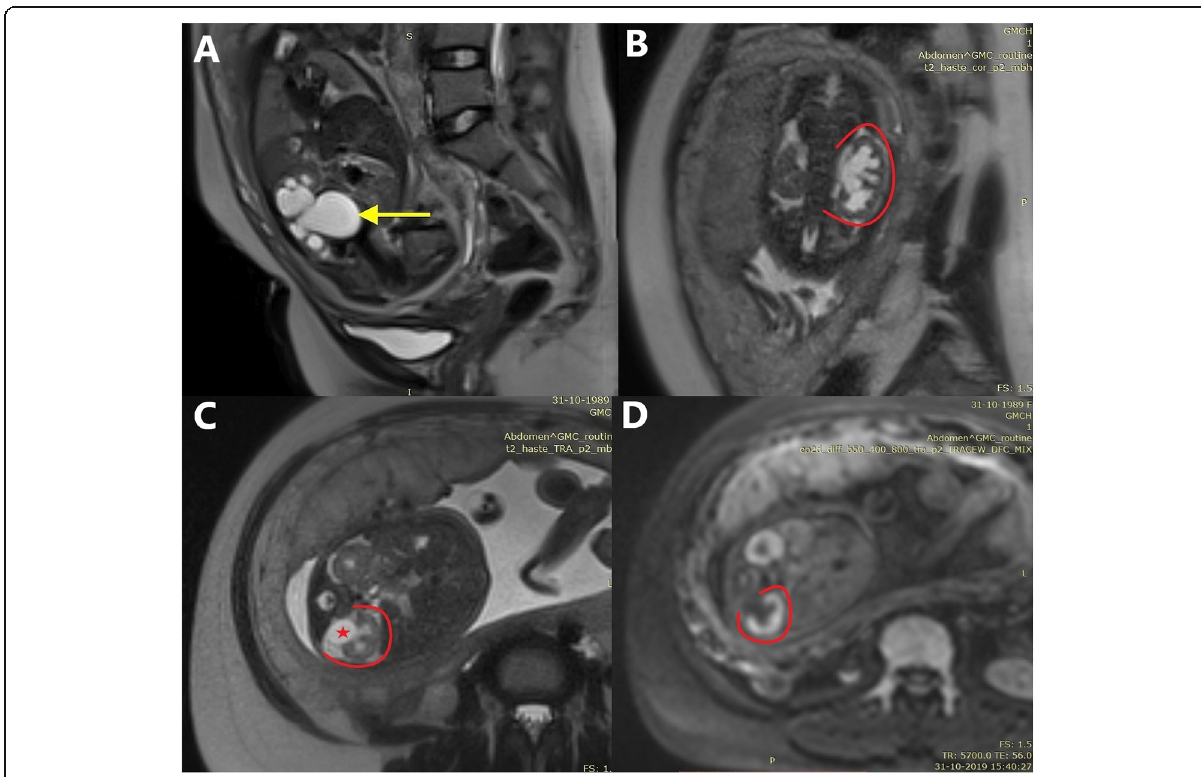
Fig. 4 a Pelviureteric junction obstruction (PUJO): maternal age: 22 years; period of gestation: 32 weeks 2 days: T2 HASTE ( a ): the right kidney shows dilatation of the pelvicalyceal system with pelviectasis out of proportion to caliectasis and non-visualization of the ipsilateral ureter consistent with PUJO (yellow arrow); b , c Unilateral hydronephrosis: T2 HASTE coronal ( b ) and axial ( c ) images show moderately dilated pelvicalyceal system (red arc) with maintained bright signal on DWI ( d ). Note the posteriorly directed renal pelvis (asterisk) suggestive of